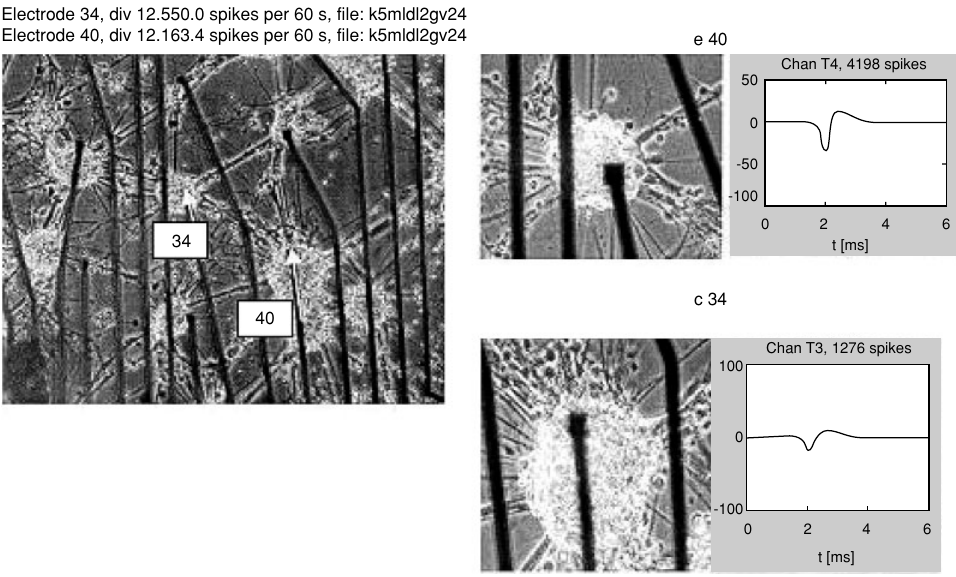
Figure 5 Example of spontaneous bioelectrical activity from cortical neurons seeded onto a PEI-microprinted multi-electrode array (12 DIV). Two islands at electrodes 34 and 40 were spontaneously active after a week. Electrode separation is 190 µ m. Islands became interconnected later and showed synchronized behavior (Figure 6). Details on the right side show the two clusters and the derived averaged spike waveform (top: electrode 40, 4198 spikes; bottom: electrode 34, 1276 spikes).